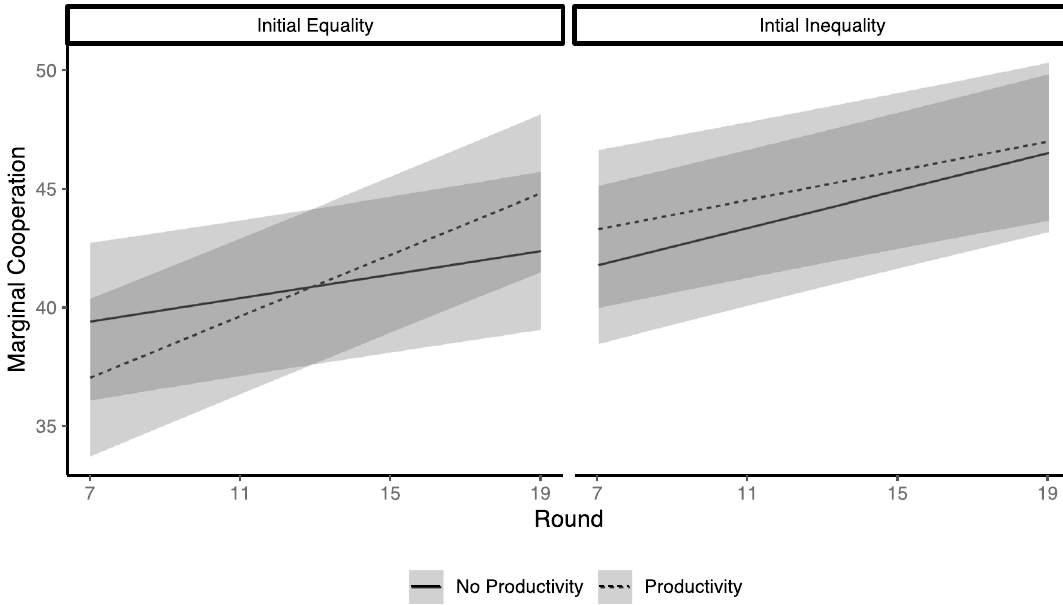
Figure 3. Marginal cooperation illustrating the interaction between wealth productivity, baseline inequality and